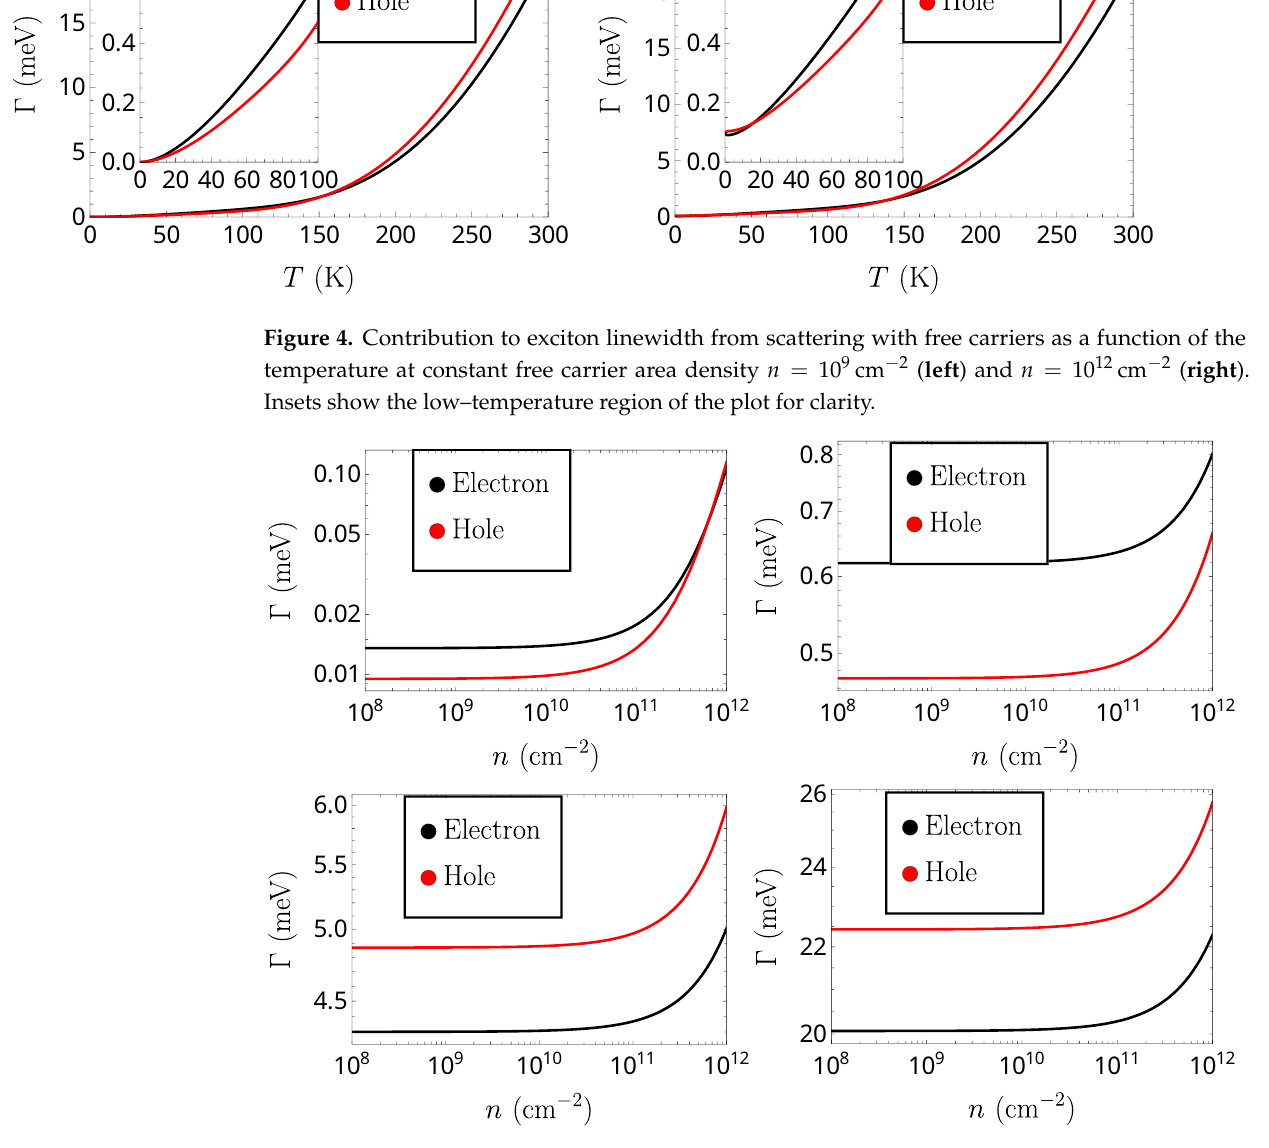
Figure 5. Contribution to exciton linewidth from scattering with free carriers as a function of the free carrier area density at constant temperature T = 10K ( top-left ), T = 100K ( top-right ), T = 200K ( bottom-left ), and T = 300K ( bottom-right